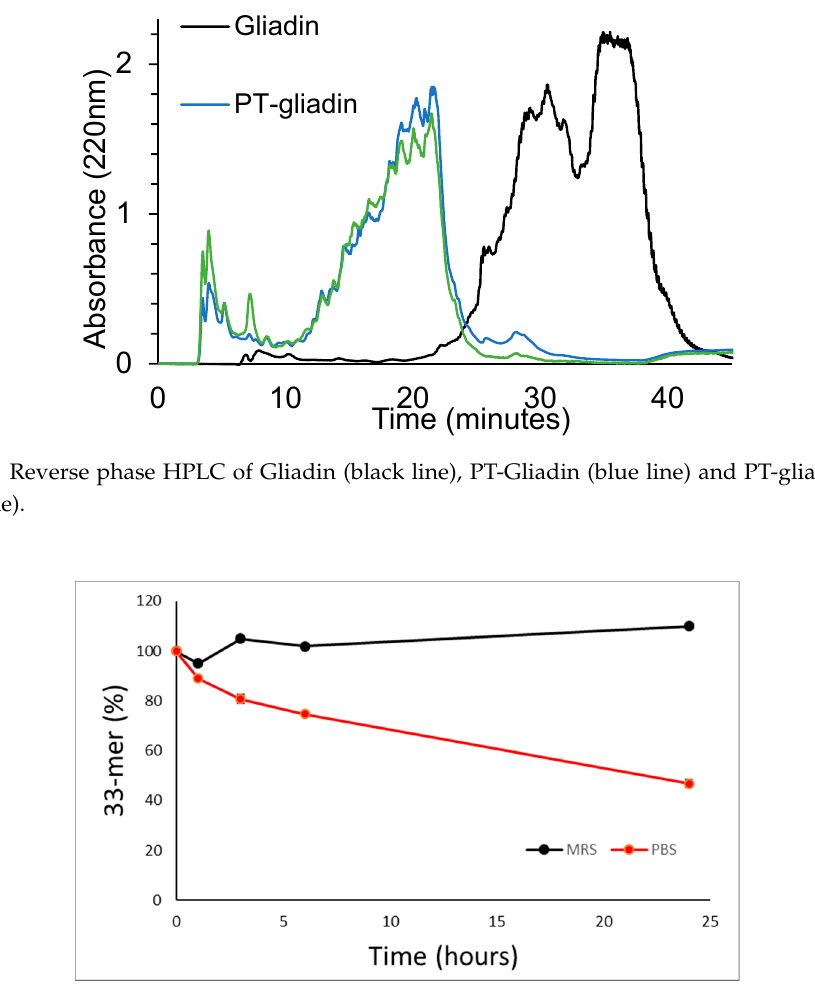
Figure 5. Left panel: Chromatographic profile and the mass spectrum of [MH +4 = 978,2] of 33-mer peptide in chymo-gliadin. Right panel: Chromatographic profile and the mass spectrum corresponding to the same retention time of expected [MH +4 = 978,2] of chymo-gliadin after probiotic digestion.